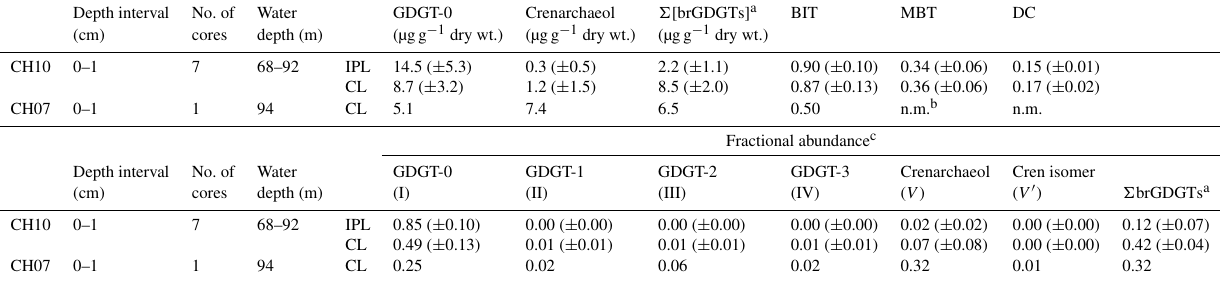
Table 1. Mean ( ± σ ) GDGT concentrations, indices, and distributions in CH10 and CH07 surface sediments. CH07 sediment data are collated from Sinninghe Damsté et al. (2009) and CH10 sediment data are collated from Buckles et al. (2014). Depth interval No. of Water